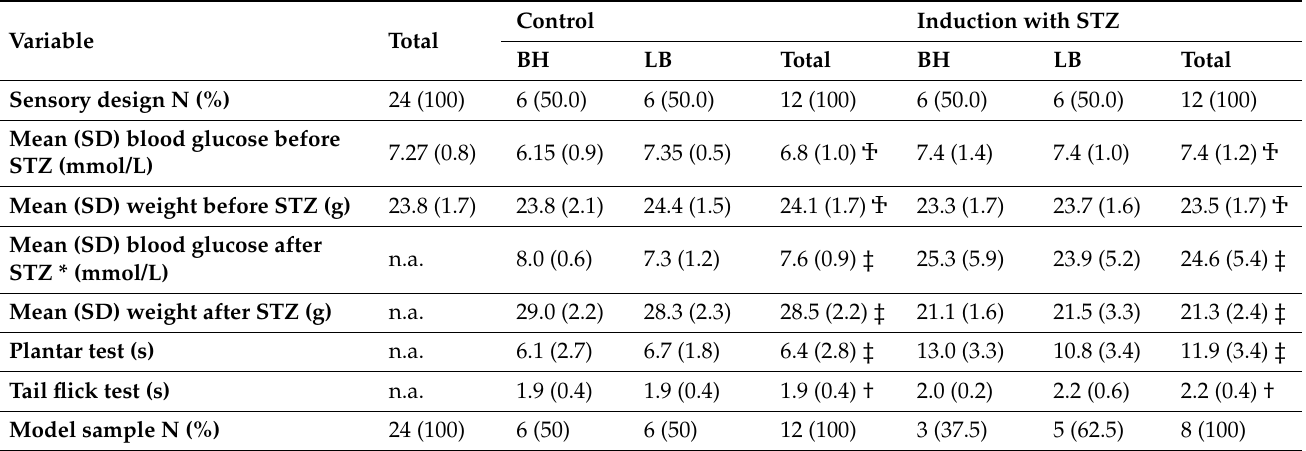
Table 1. Description of the sample characteristics in the control mice and mice induced with STZ for both treatments.